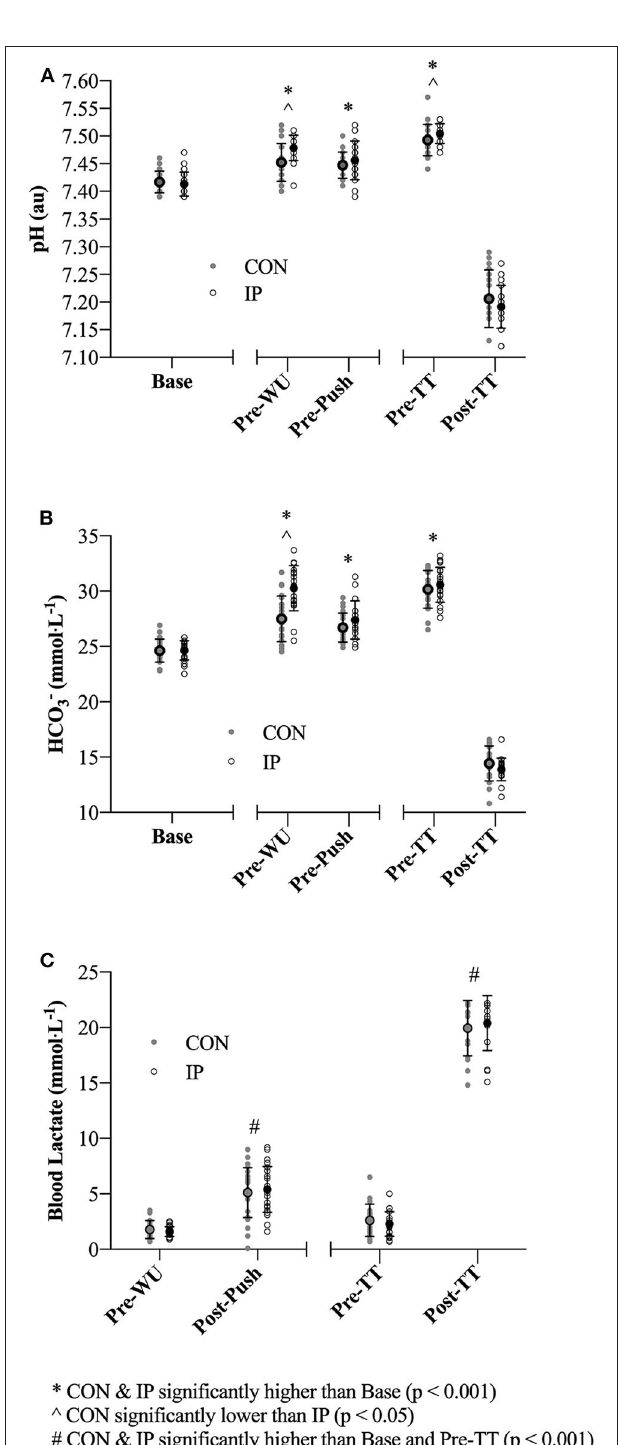
FIGURE 3 | (A–C) Blood acid-base and lactate (BLa) measurements obtained at baseline (Base; with the exception of BLa), pre-warm-up (Pre-WU), 1min post lactate push (Post-Push), pre time trial (Pre-TT) and 1min post completion of the TT (Post-TT). Individual and mean ± SD data are presented for both the consensus standard (CON; gray dots) and individualized peak (IP; open black circles)